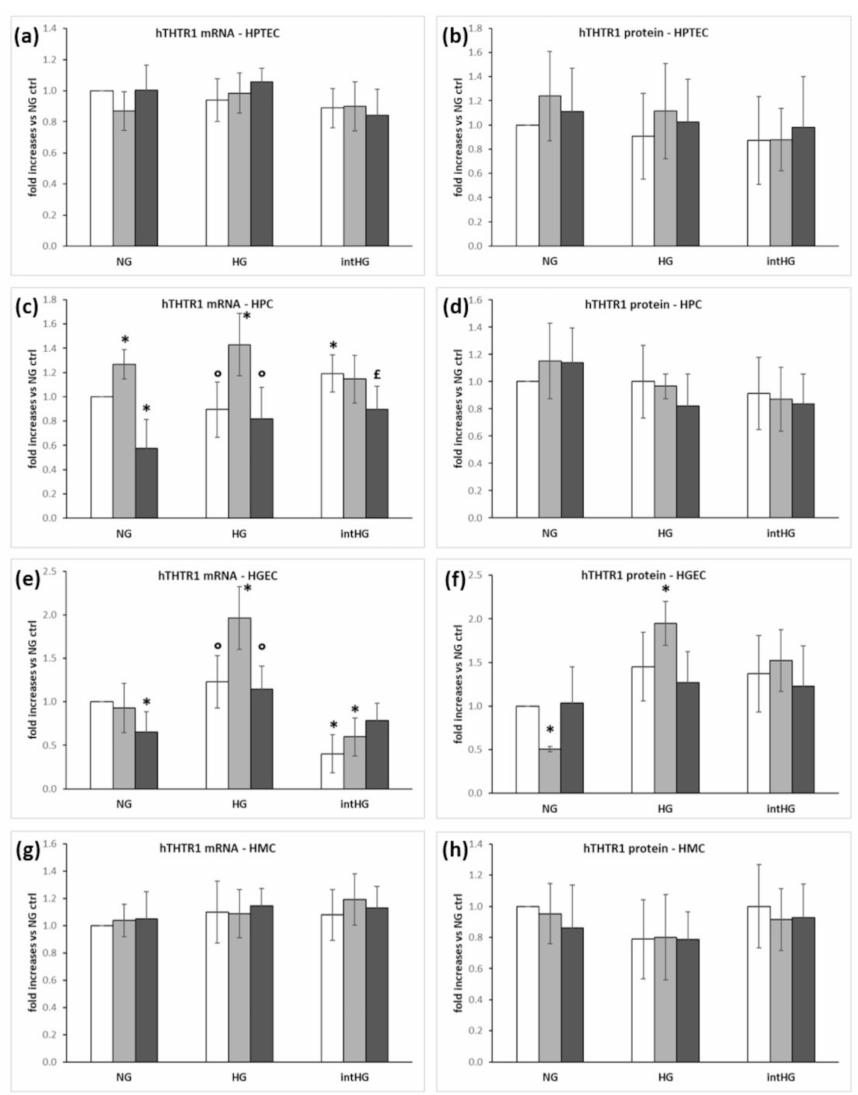
Figure 3. THTR1 expression in renal glomerular cells under different experimental conditions. ( a ) THTR1 mRNA and ( b ) protein expression in HPTEC; ( c ) THTR1 mRNA and ( d ) protein expres- sion in HPC; ( e ) THTR1 mRNA and ( f ) protein expression in HGEC; ( g ) THTR1 mRNA and ( h ) protein expression in HMC. White bars: physiological thiamine concentrations (ctrl); light grey bars: thiamine-deficient medium (TD); dark grey bars: high thiamine concentrations (HT). NG = physiological glucose concentrations; HG = high glucose concentrations; intHG = intermittent high glucose concentrations. Mean of 5 experiments ± SD. * p < 0.05 vs. NG ctrl; ◦ p < 0.05 vs. HG TD; £ p < 0.05 vs. intHG ctrl and intHG